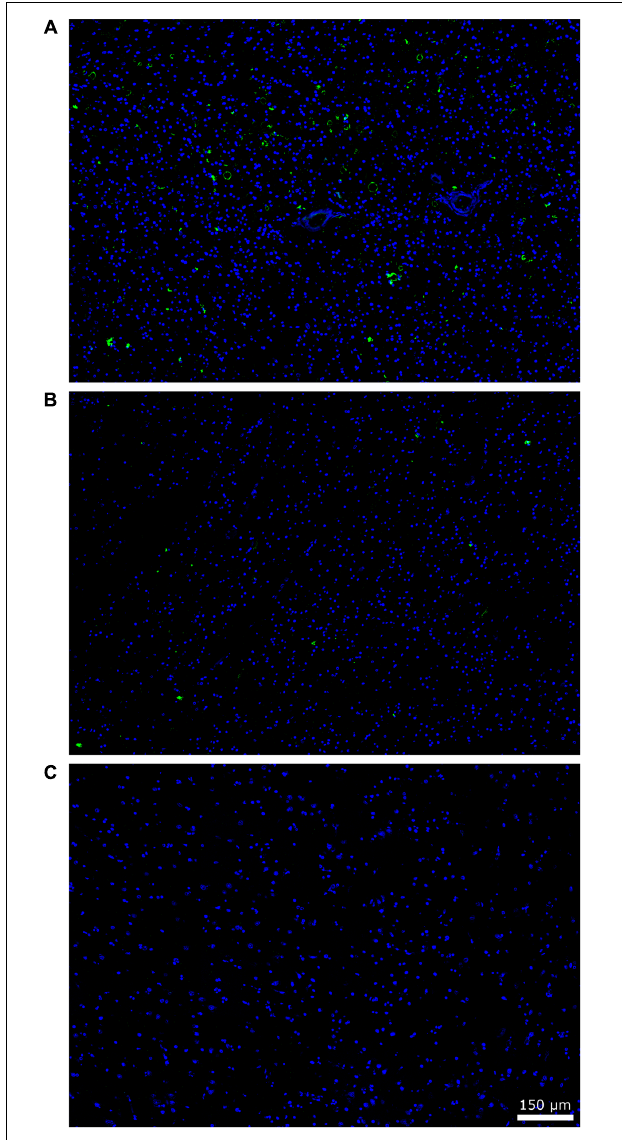
FIGURE 1 | Immunohistochemistry of fungal structures brain sections. Paraffin-embedded brain sections (5 µ m) were processed as described (see section “Materials and Methods”). Sections were incubated with rabbit polyclonal anti- C. albicans antibodies (1:100) and an Alexa 488-conjugated donkey anti-rabbit antibody (1:500) (green) and stained with DAPI (blue). A wide file (20 × magnification) is shown for the ERH brain section of patient AD11 (A) , an elderly subject (C13) (B) , and a younger subject (C10) (C) . Scale bar is shown in the